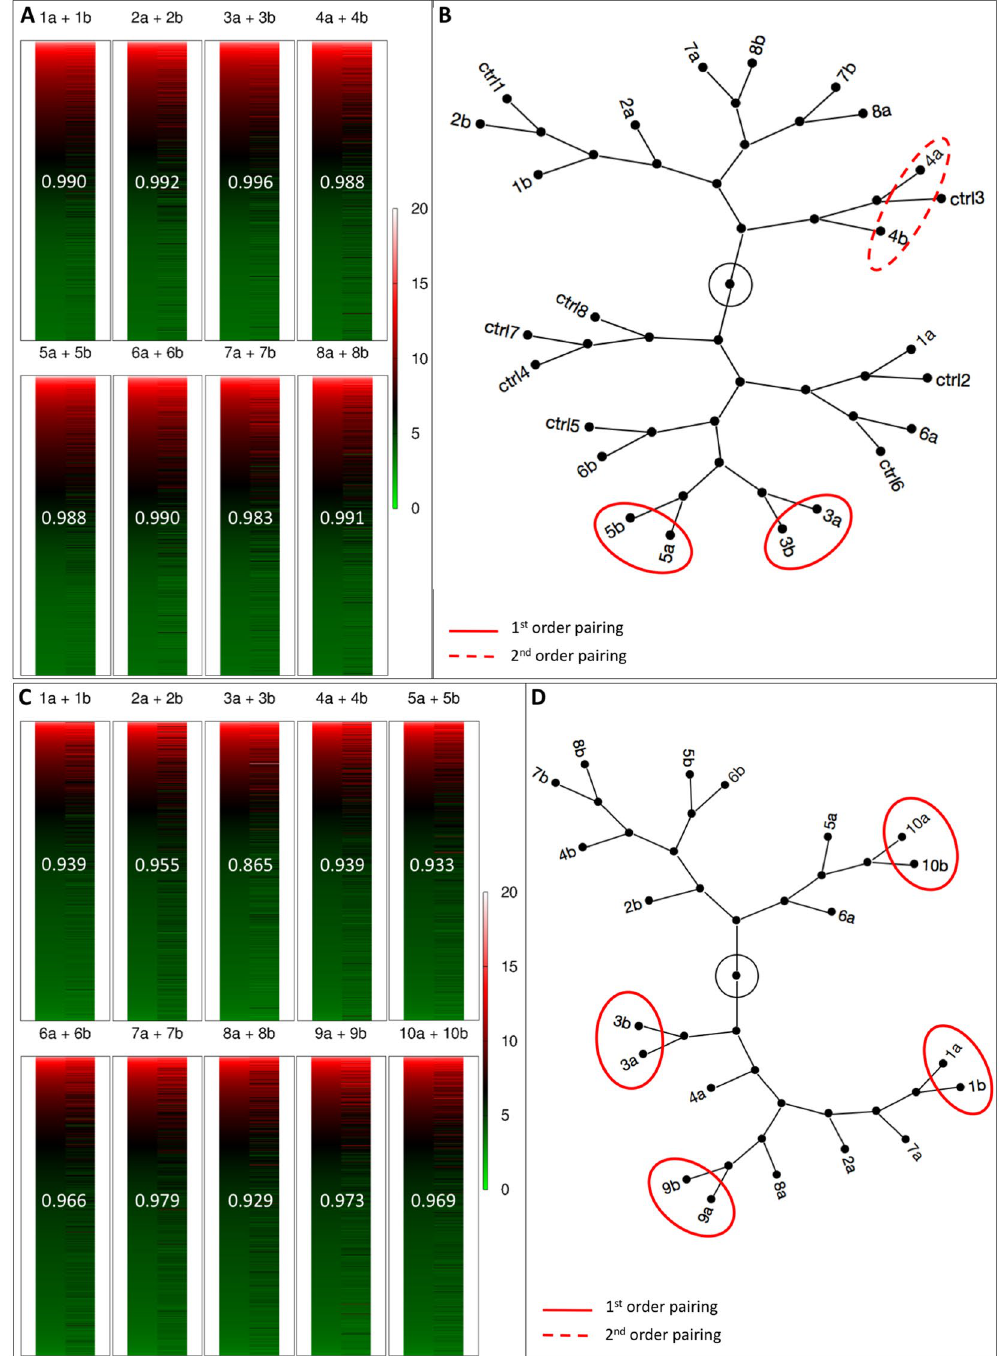
Figure 5. Transcriptome analysis of MZ twin pairs. Individual transcriptomes are shown as heat maps, with higher expression coded in red and lower expression coded in green, and linear correlation coefficient written on the heat maps ( A , C ). Constellation maps of the transcriptomes of individual blastocysts ( B ) and individual two-cell stage blastomeres ( D ) identified with both a number (for the original embryo subjected to bisection) and a letter (for the two members resulting from bisection). Unmanipulated embryos in B are labeled as controls (ctrl). The transcriptomes were subjected to hierarchical clustering analysis to see if they would return the original pair associations (e.g. 1a-1b,